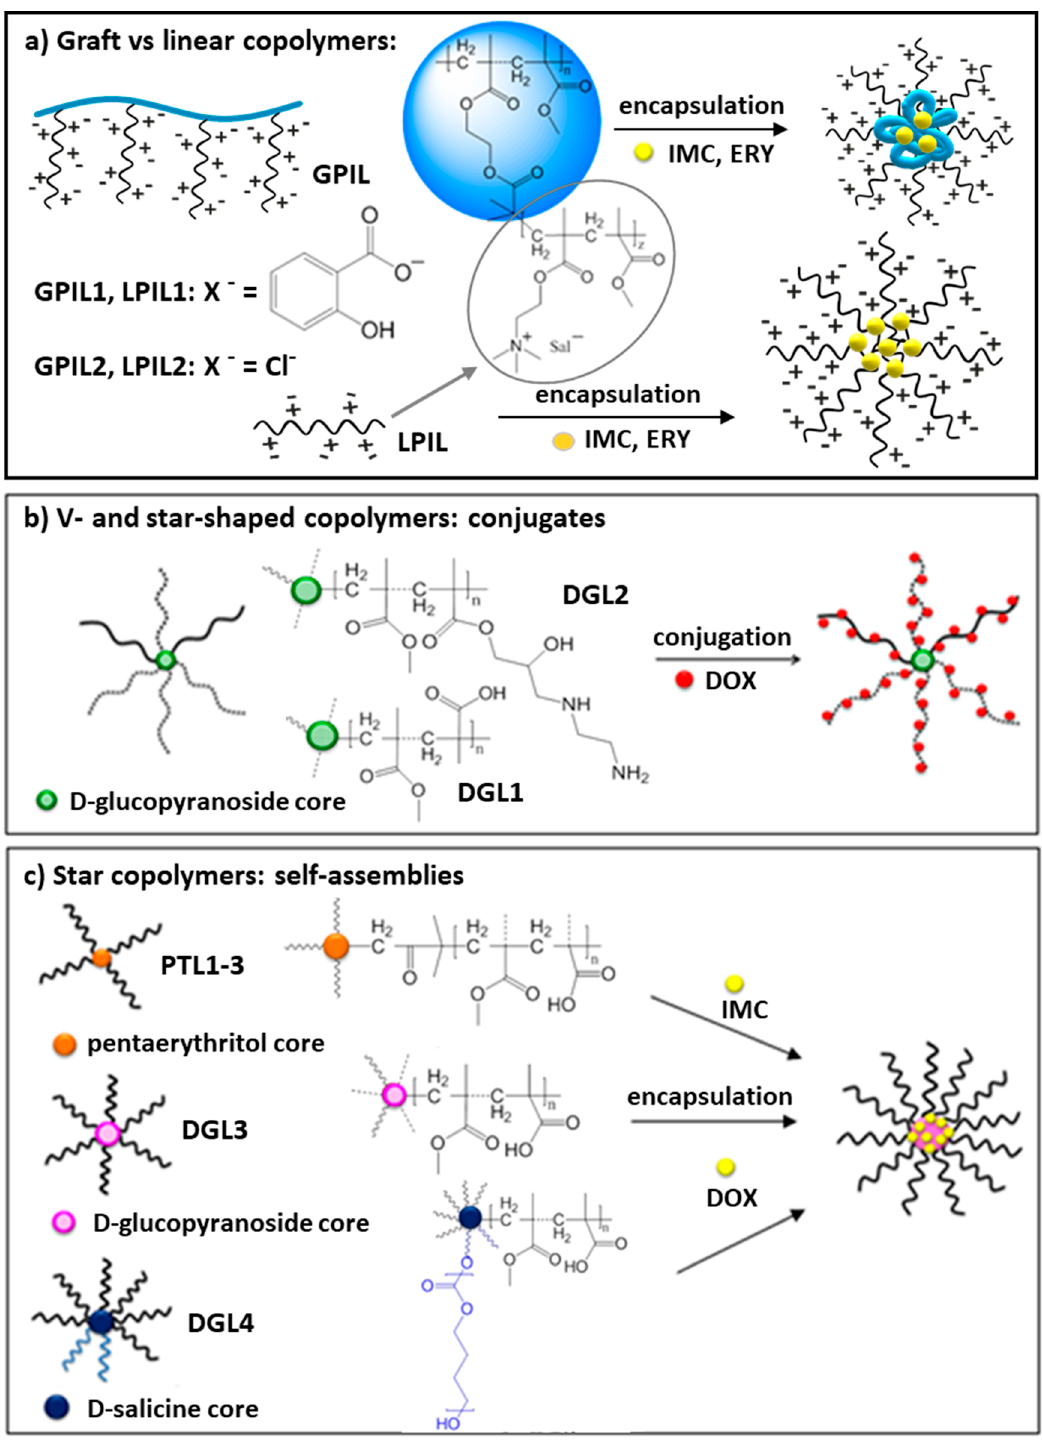
Figure 1. Drugs carried by grafted poly(ionic liquid)s (GPIL) ( a ), and star shaped polymers (DGL, PTL) ( b – c ), in the form of conjugates and self-assemblies.